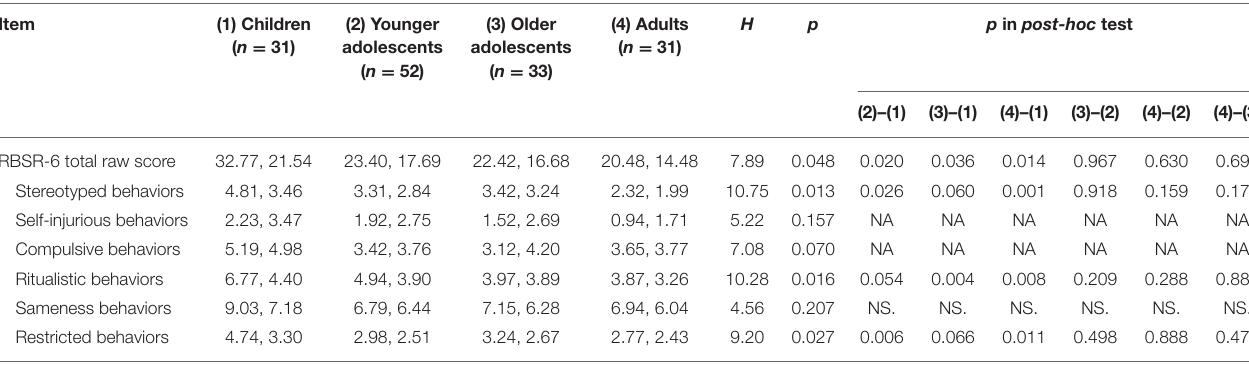
TABLE 2 | Description of RRBIs in different age groups ( n = 147).